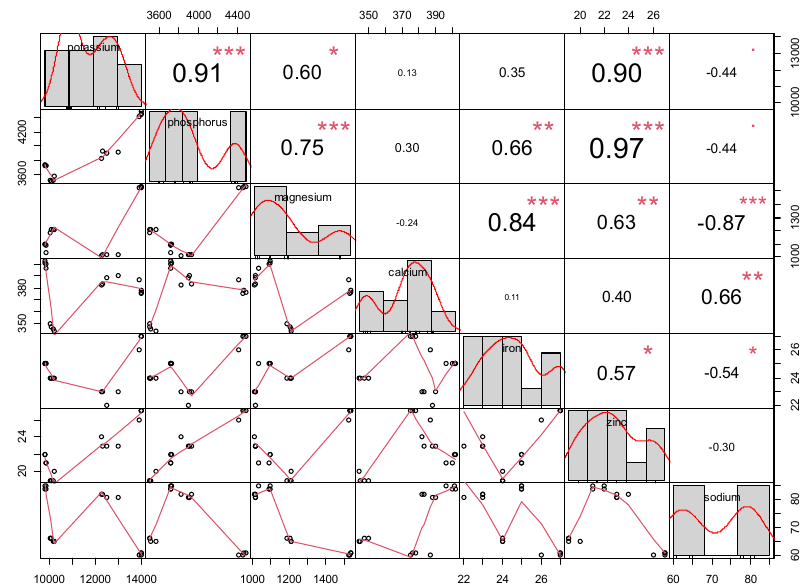
Figure 1. Correlation matrix of macro- and microelement concentrations (mg kg − 1 dry matter). Note: *** ( p < 0.001), ** ( p < 0.01), * ( p < 0.05). In the second step of the precision farming of sweet maize, the element yield per unit area was analysed. In almost all cases, the bivariate correlation coefficients are very high, showing a strong linear stochastic relationship. All coefficients are significant. The lower triangular matrix shows the nature of the relationship between the variables. The linear correlation is strong (Figure 2), due to high yields.